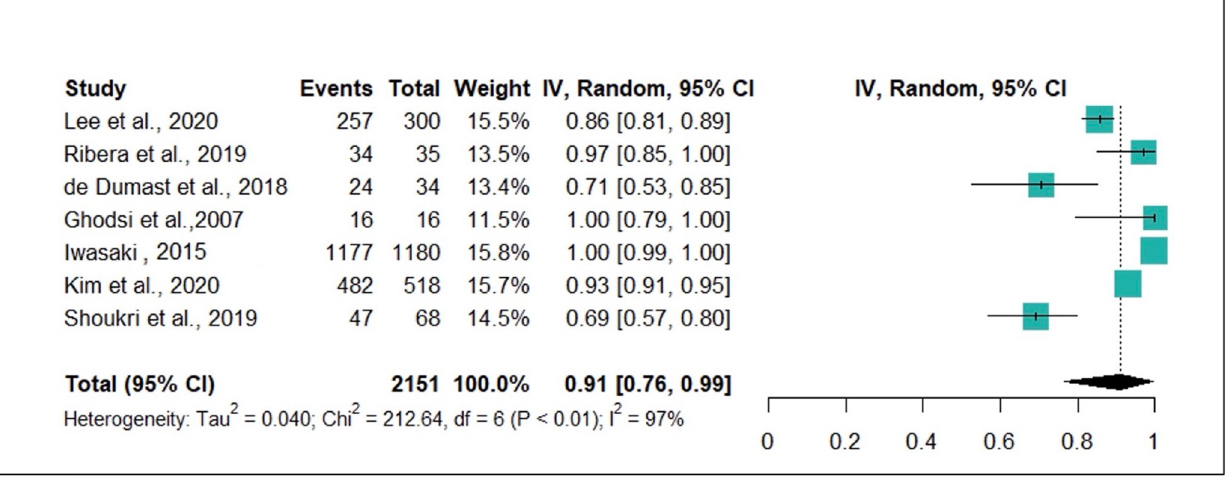
Fig 3. Meta-analysis of seven studies indicated by forest